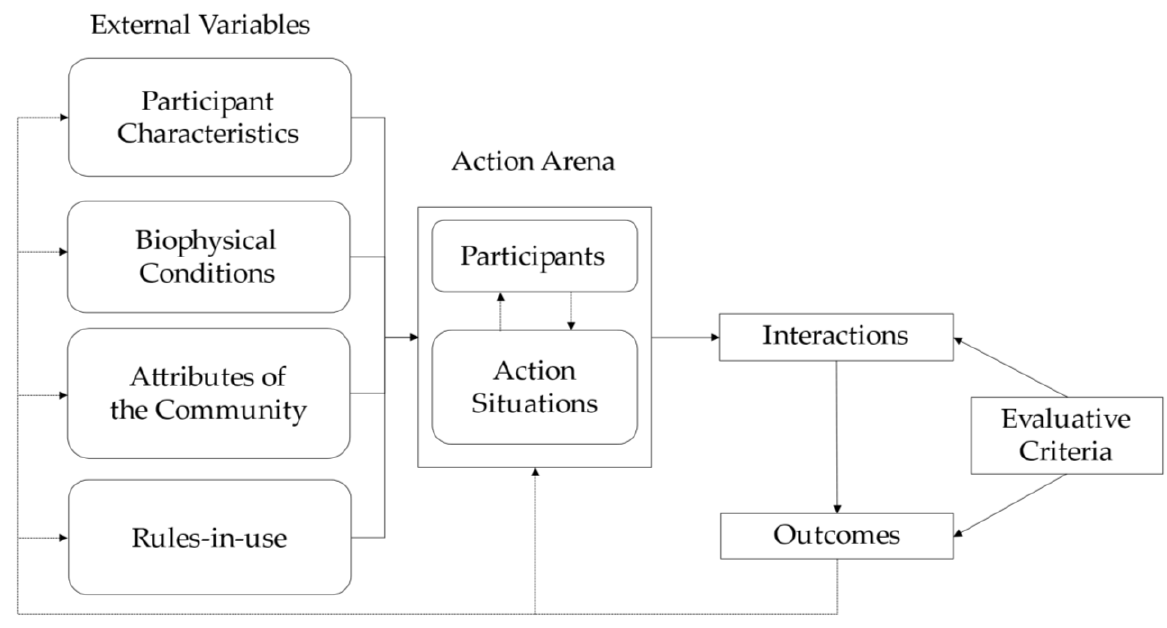
Figure 2. Institutional analysis and development